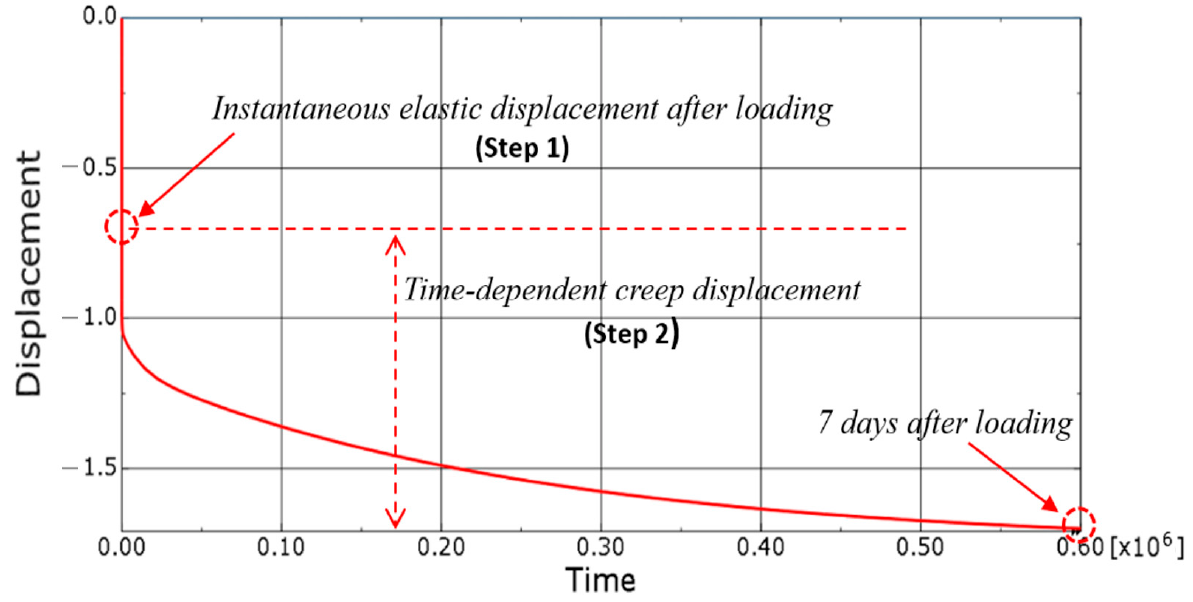
Figure 11. Example of a displacement change process by step in the FEA: ρ = 30 kg/m 3 , σ o = 0.1020 MPa.